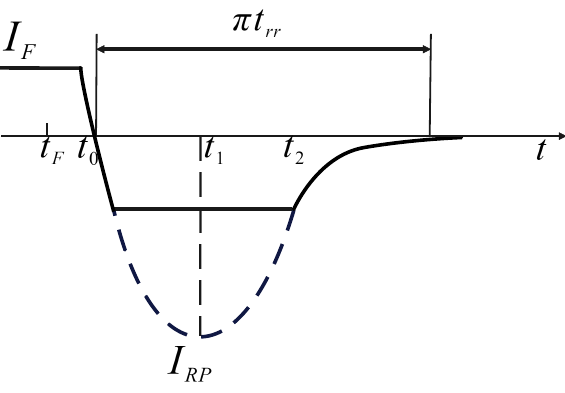
Figure 5. Reverse recovery current waveform of rectifier tube with saturable